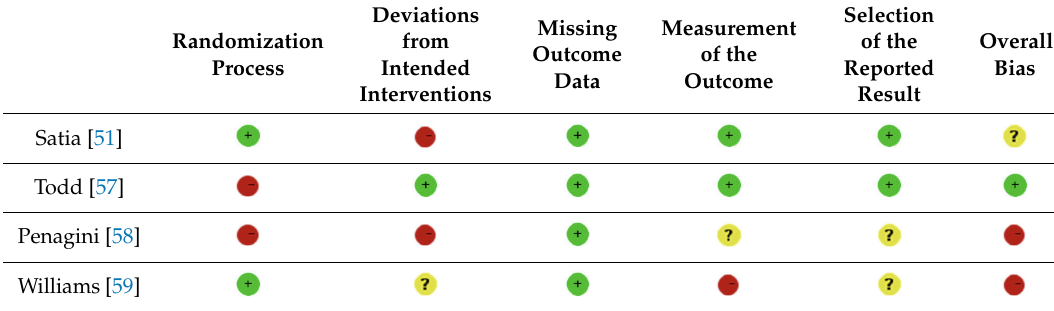
Table 3. Summary risk of bias [54] assessment of the included randomized controlled trials.